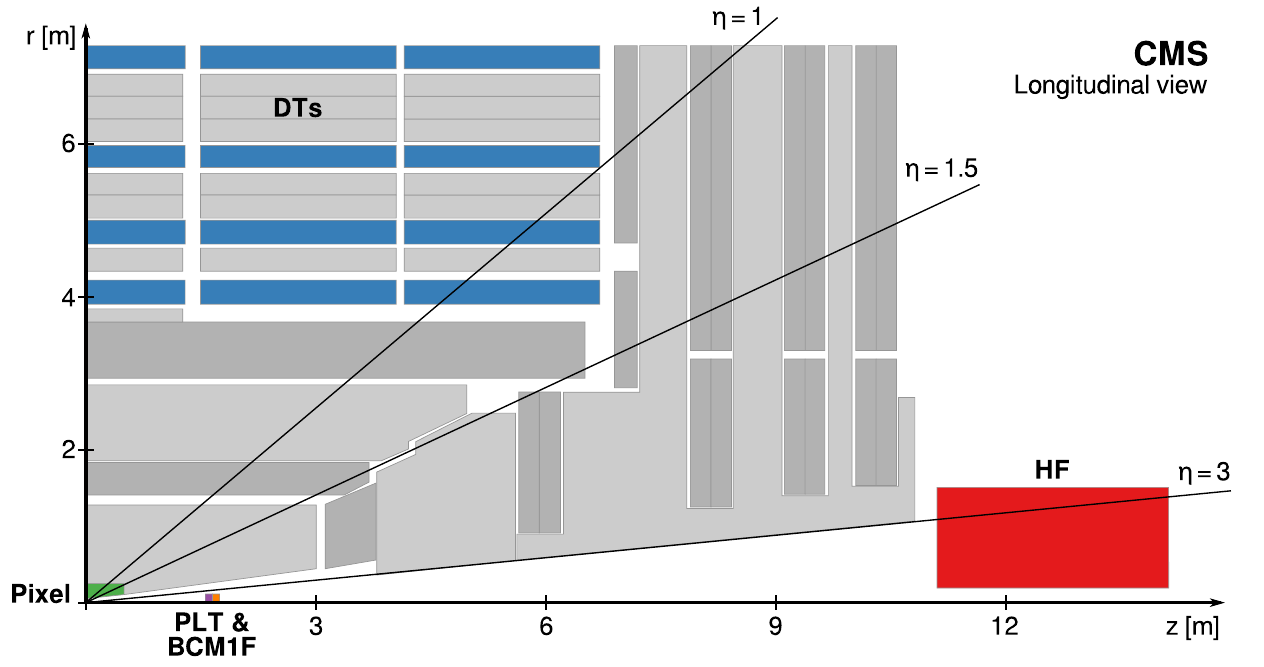
Fig. 1 Schematic cross section through the CMS detector in the r - z plane. The main luminometers in Run 2, as described in the text, are highlighted, showing the silicon pixel detector, PLT, BCM1F, DTs, and HF. The two RAMSES monitors used as a luminometer in Run 2 are located directly behind HF. In this view, the detector is symmetric about